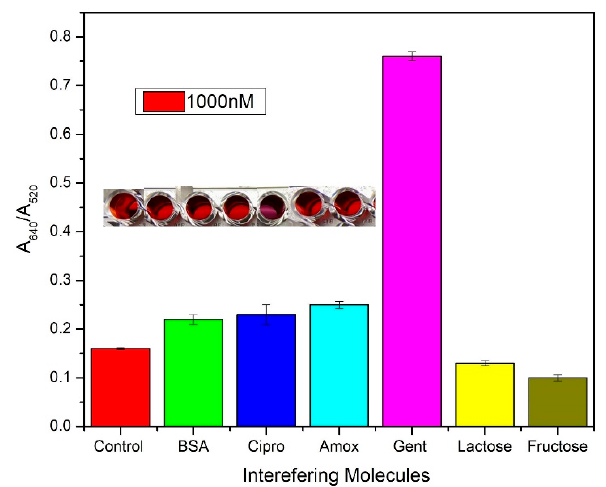
Figure 10. Interference studies performed with different molecules—bovine serum albumin (BSA), ciprofloxacin, amoxicillin, gentamicin, lactose and fructose by adding 200 µL AuNP + 1 µM GA + 1000 nM of interfering molecule in TE buffer (pH 7.4) + 280 mM NaCl. Inset: photograph of the well plate showing color change in the order of interfering molecules.